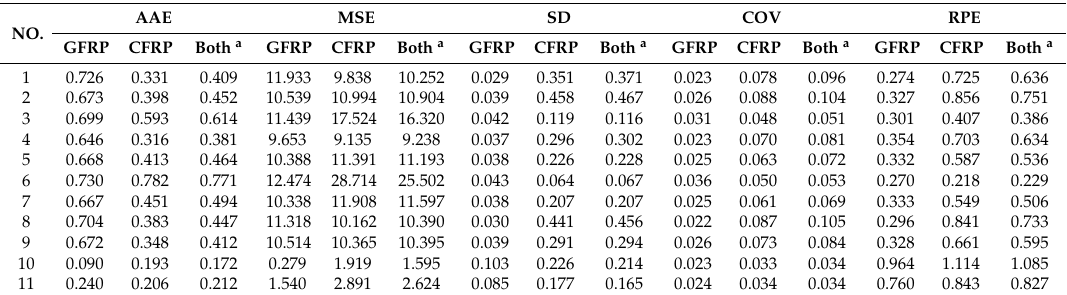
Table 10. Statistical assessment of the ultimate strain models.